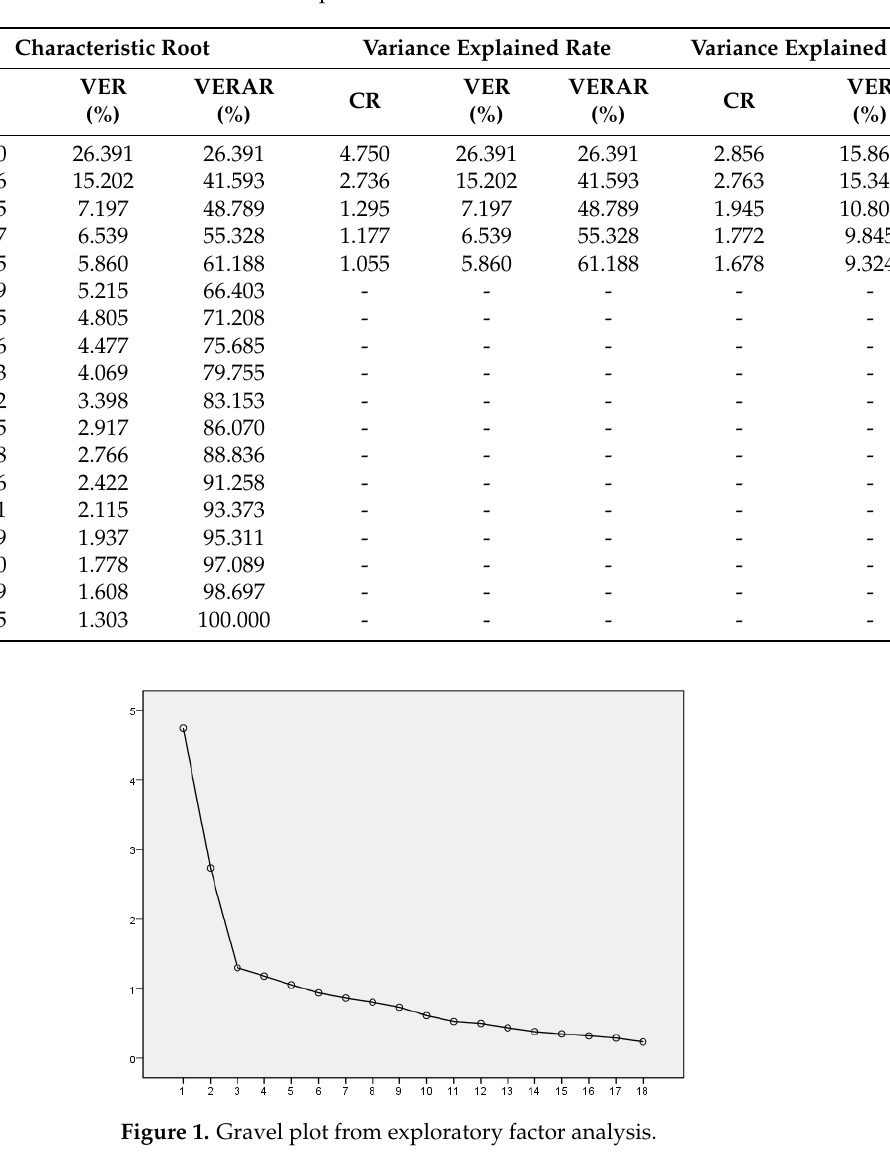
Table 3. Variance explained rate.